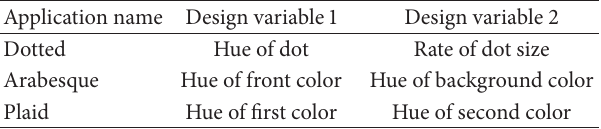
Table 2: Design variables of experimental